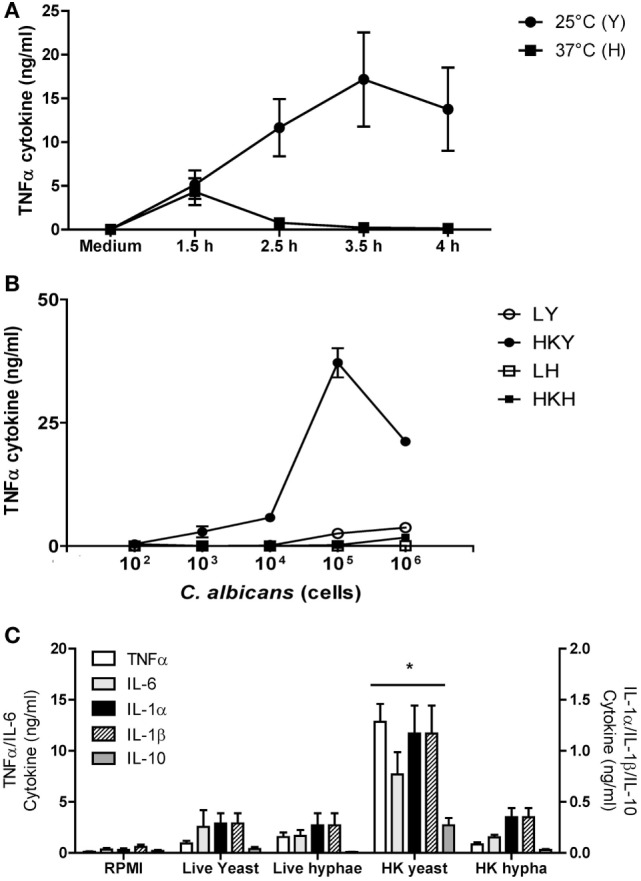
TNFα stimulation with Candida albicans yeast and hyphal cells by human peripheral blood mononuclear cells (PBMCs). (A) Cytokine production by human PBMCs stimulated with yeasts cells (Y) of C. albicans NGY152 grown at 25°C (closed circles) or hyphae (H) grown at 37°C (closed squares) in RPMI 1640 + 2.5% fetal calf serum (FCS). Error bars = SEM (n = 3). (B) Dose-dependent stimulation of TNFα production by human PBMCs when stimulated with different forms of C. albicans NGY152 grown in RPMI 1640 + 2.5% FCS. Heat-killed yeasts (HKY), closed circles; live yeasts (LY), open circles; HK hyphae (HKH), closed squares; live hyphae (LH), open squares. Error bars = SEM (n = 6). In these experiments, a total of 5 × 105 PBMCs were used in each treatment and so the MOI varied from 0.0002:1 to 2:1. (C) Cytokine production by human PBMCs stimulated with the different morphological forms of C. albicans NGY152. In each treatment, an inoculum of 1 × 106 cells/ml was used. Results are means ± SEM (n = 6; *p < 0.05).